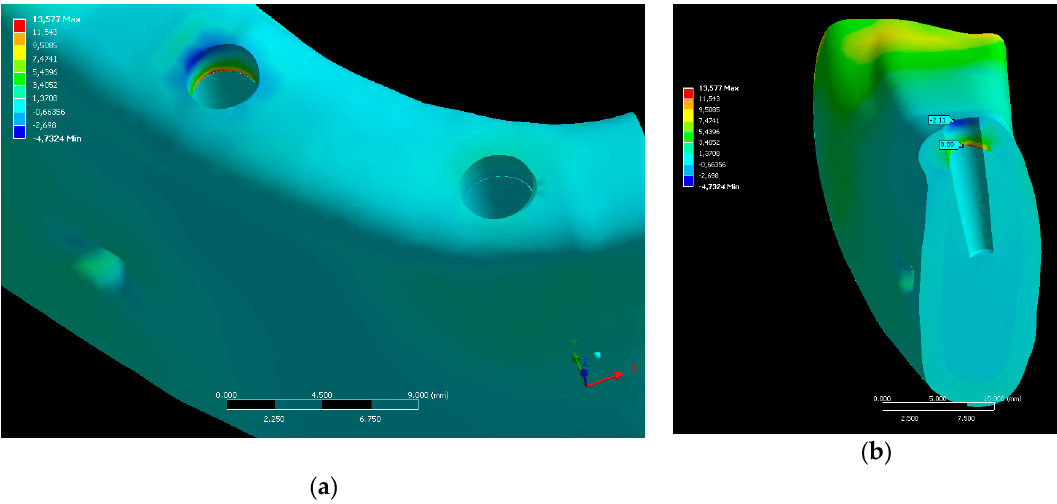
Figure 7. Maximum principal stress [MPa] in the M1 group: ( a ) three-dimensional view; ( b ) transversal cut of the bone.